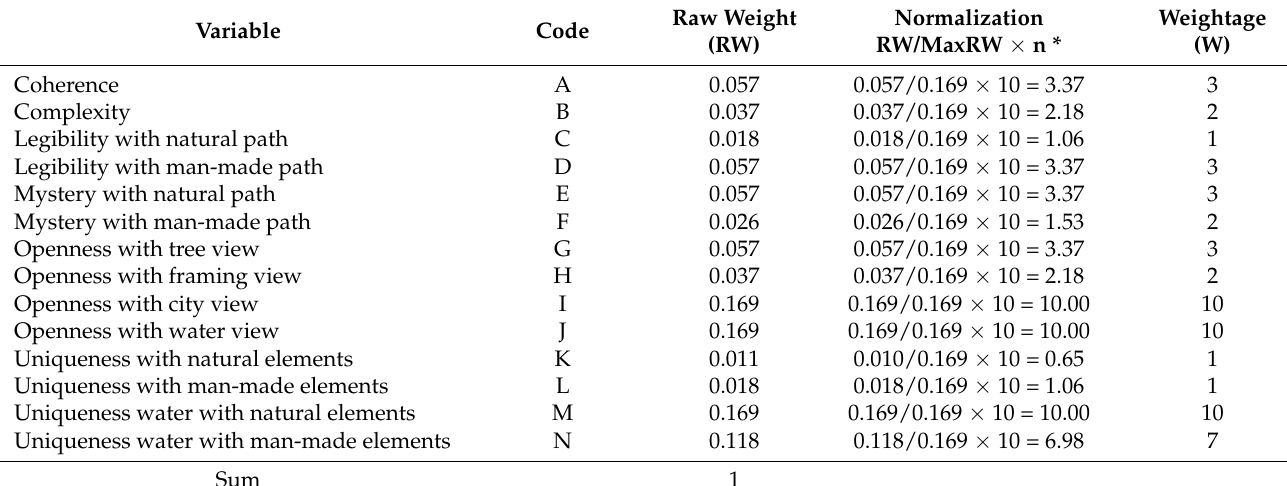
Table 10. Determination of the weightage of the multiple